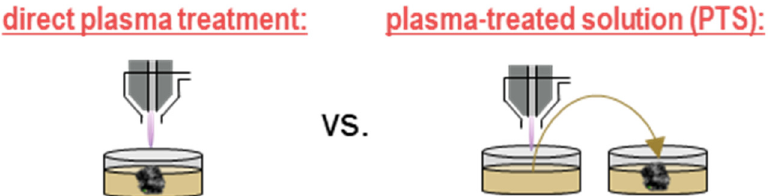
Figure 1. Direct plasma treatment exposes the biological target such as in vitro cells or in vivo or ex vivo tissue directly to the plasma gas phase. Plasma-treated solution (PTS), in turn, is generated by exposing a solution to the plasma gas phase and subsequently transferring this liquid to a target cell culture in vitro or for injection in vivo. Reproduced from [28] . Copyright 2020 MDPI.